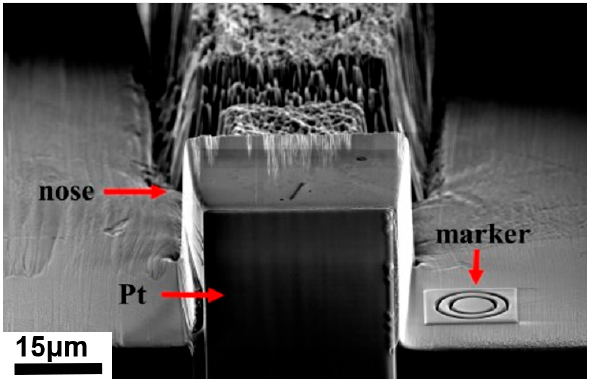
Figure 2. Schematic diagram of cutting sample.